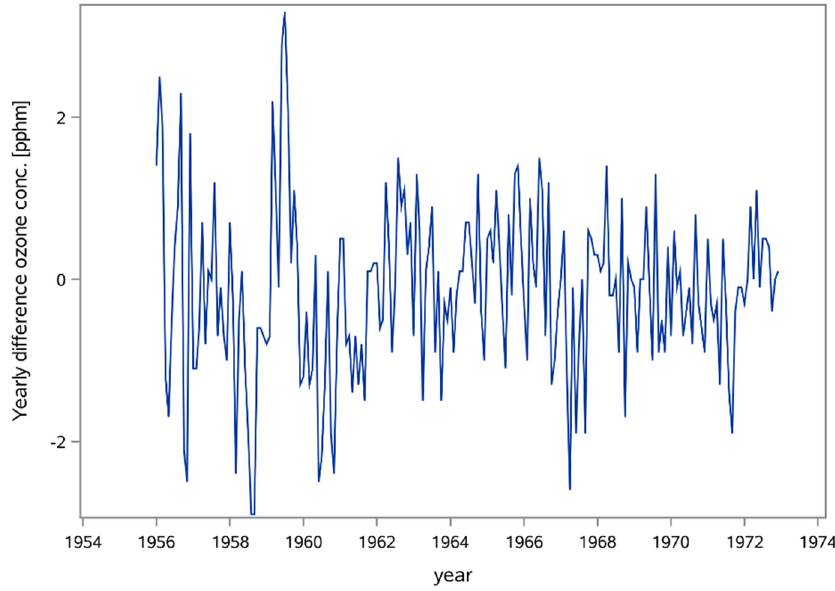
Figure 2. The 12-months differenced ozone series from January 1955 to December 1972.